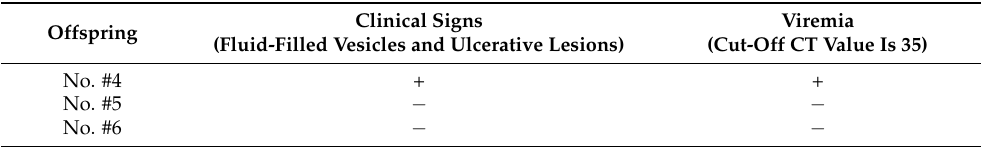
Table 1. The clinical signs and viremia state in the offspring infected by